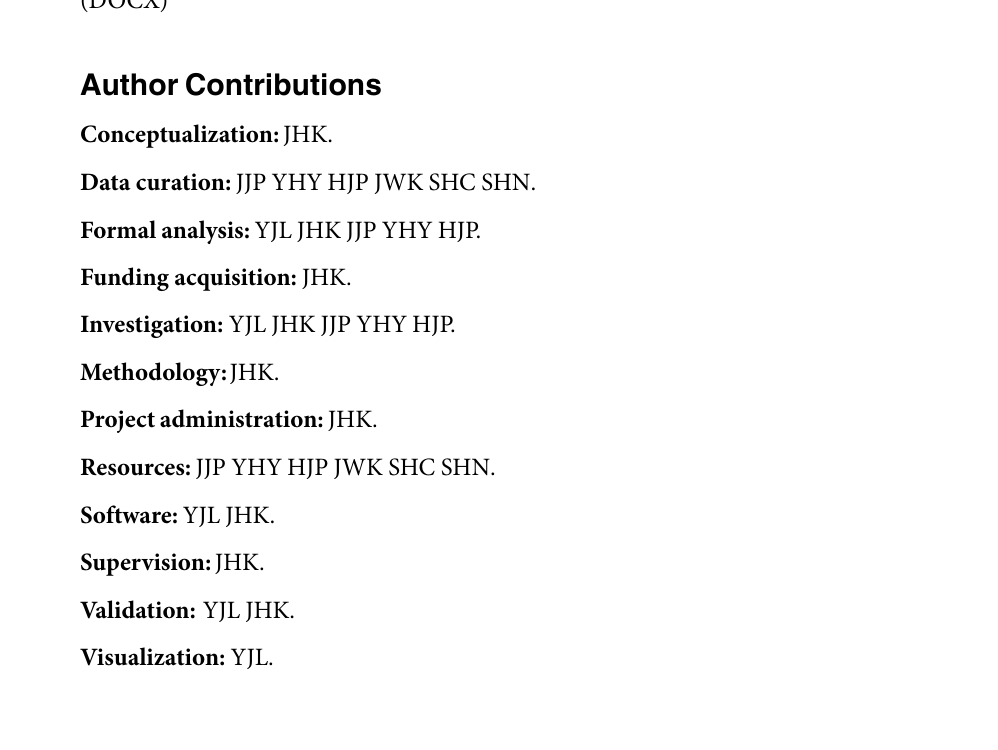
S1 Table. Biologic behaviors according to presence of ulcer in differentiated-typeearly gas- tric cancer (n = 1,669). S2 Table. Biologic behaviors according to presence of ulcer in undifferentiated-typeearly gastric cancer (n = 1,601). S3 Table. Biologic behaviors according to the stage of ulcer in differentiated-typeearly gas- tric cancer (n = 1,142). S4 Table. Biologic behaviors according to the stage of ulcer in undifferentiated-typeearly gastric cancer (n = 1,201). S5 Table. Univariate and multivariate analysis of risk factors for lymph node metastasis in differentiated-typegastric cancer (n = 1,669). S6 Table. Univariate and multivariate analysis of risk factors for lymph node metastasis in undifferentiated-typegastric cancer (n =